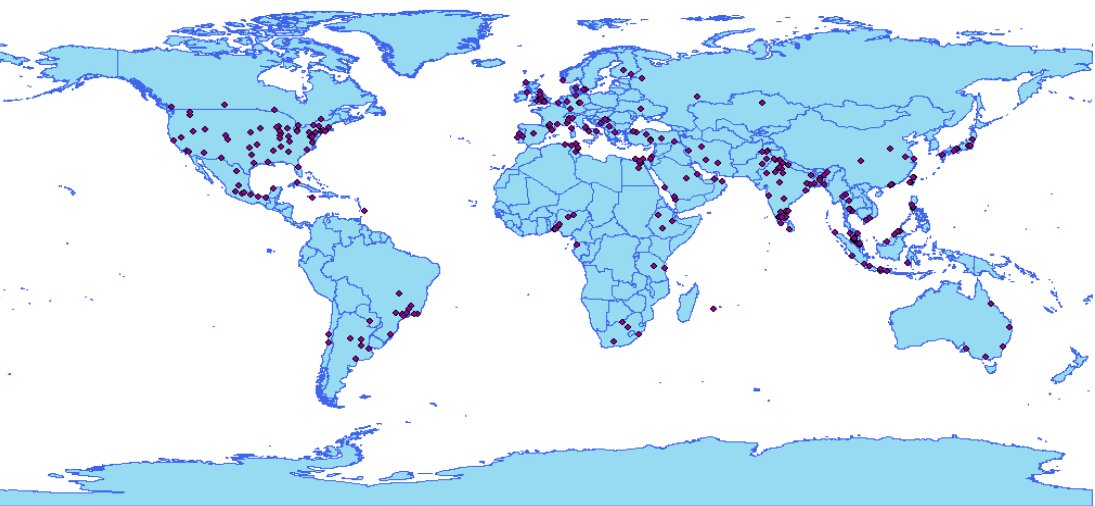
Figure 6. Geocoding of the organizations responsible for the publication of the 332 articles analyzed.